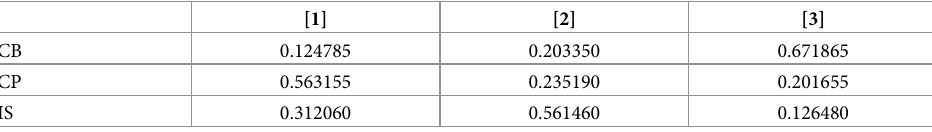
Table 9. Rank probabilities of fixation methods for VAS score.